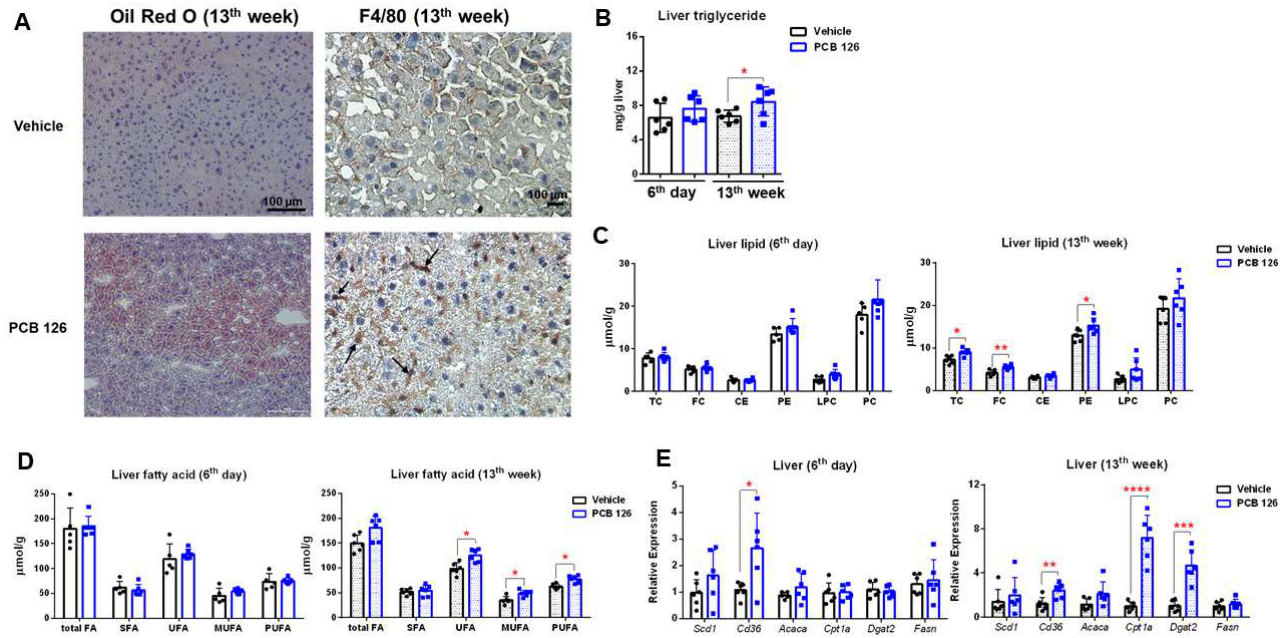
Figure 3. Effects of early life PCB 126 exposure on hepatic lipid metabolism. ( A ) Oil Red O and F4/80-positive cells staining in the liver from mice with vehicle or PCB 126 exposure. ( B ) Liver triglyceride levels from mice with vehicle or PCB 126 exposure. ( C , D ) Quantitative NMR analysis of liver lipid ( C ) and fatty acid ( D ) profiling from mice with vehicle or PCB 126 exposure. ( E ) qPCR analysis of mRNA encoding de novo fatty acid biosynthesis in liver from mice with vehicle or PCB 126 exposure. Values are means ± S.D. ( n = 6 per group). * p < 0.05, ** p < 0.01, *** p < 0.001, **** p < 0.0001 compared to vehicle. TC, total cholesterol; FC, free cholesterol; CE, cholesterol ester; PE, phosphatidylethanolamine; LPC, lysophosphatidylcholine; PC, phosphatidylcholine; FA, fatty acid; SFA, saturated fatty acid; UFA, unsaturated fatty acid; MUFA, monosaturated fatty acid; PUFA, polyunsaturated fatty